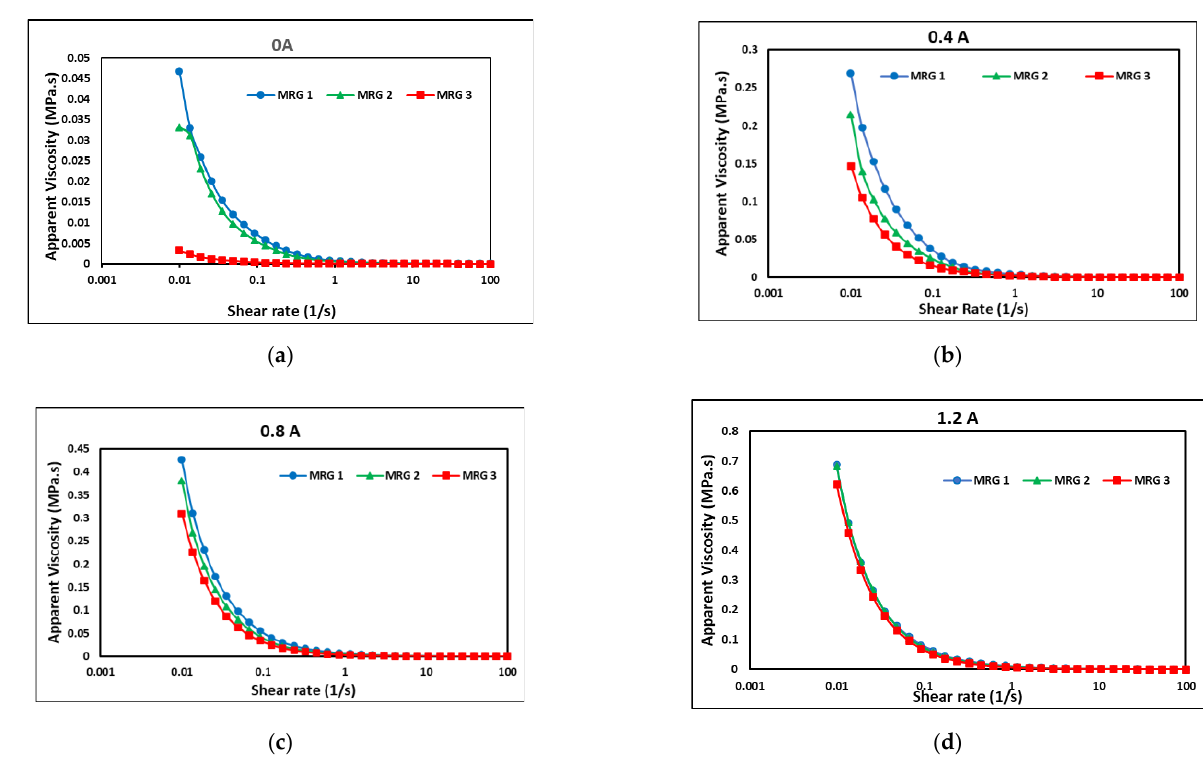
Figure 6. The viscosity of the MRG samples at ( a ) 0, ( b ) 0.4, ( c ) 0.8, and ( d ) 1.2 A of